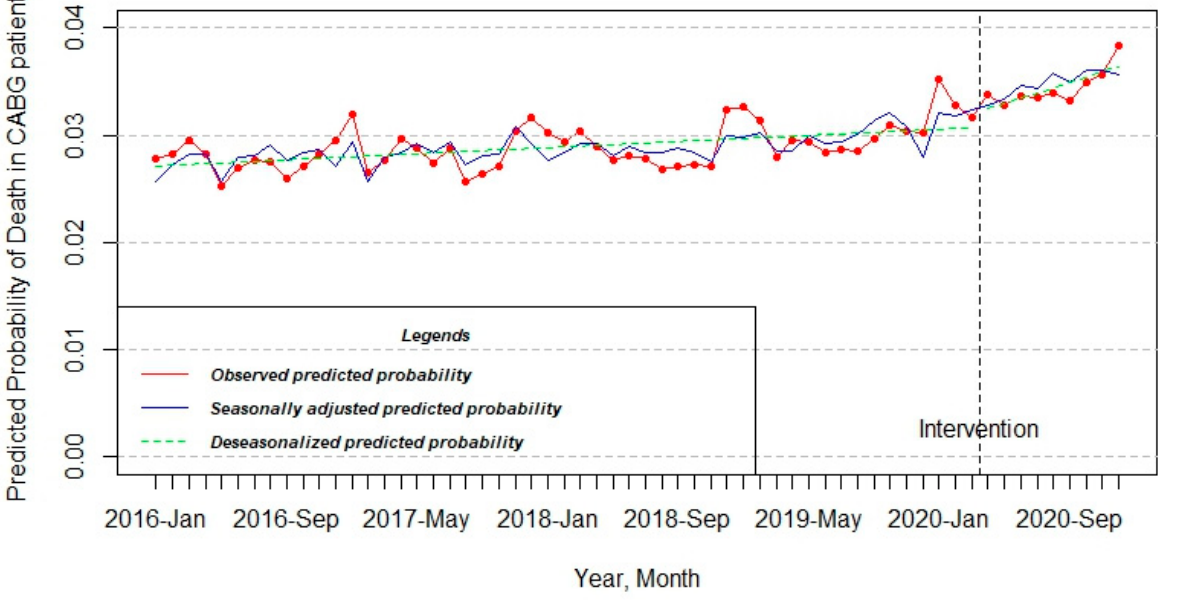
Figure 4. Interrupted time series model of the change of predicted probability of death in patients who underwent CABG. Table 1. Summary of CABG and PCI ordinary least squares models with included dummy variables for months.